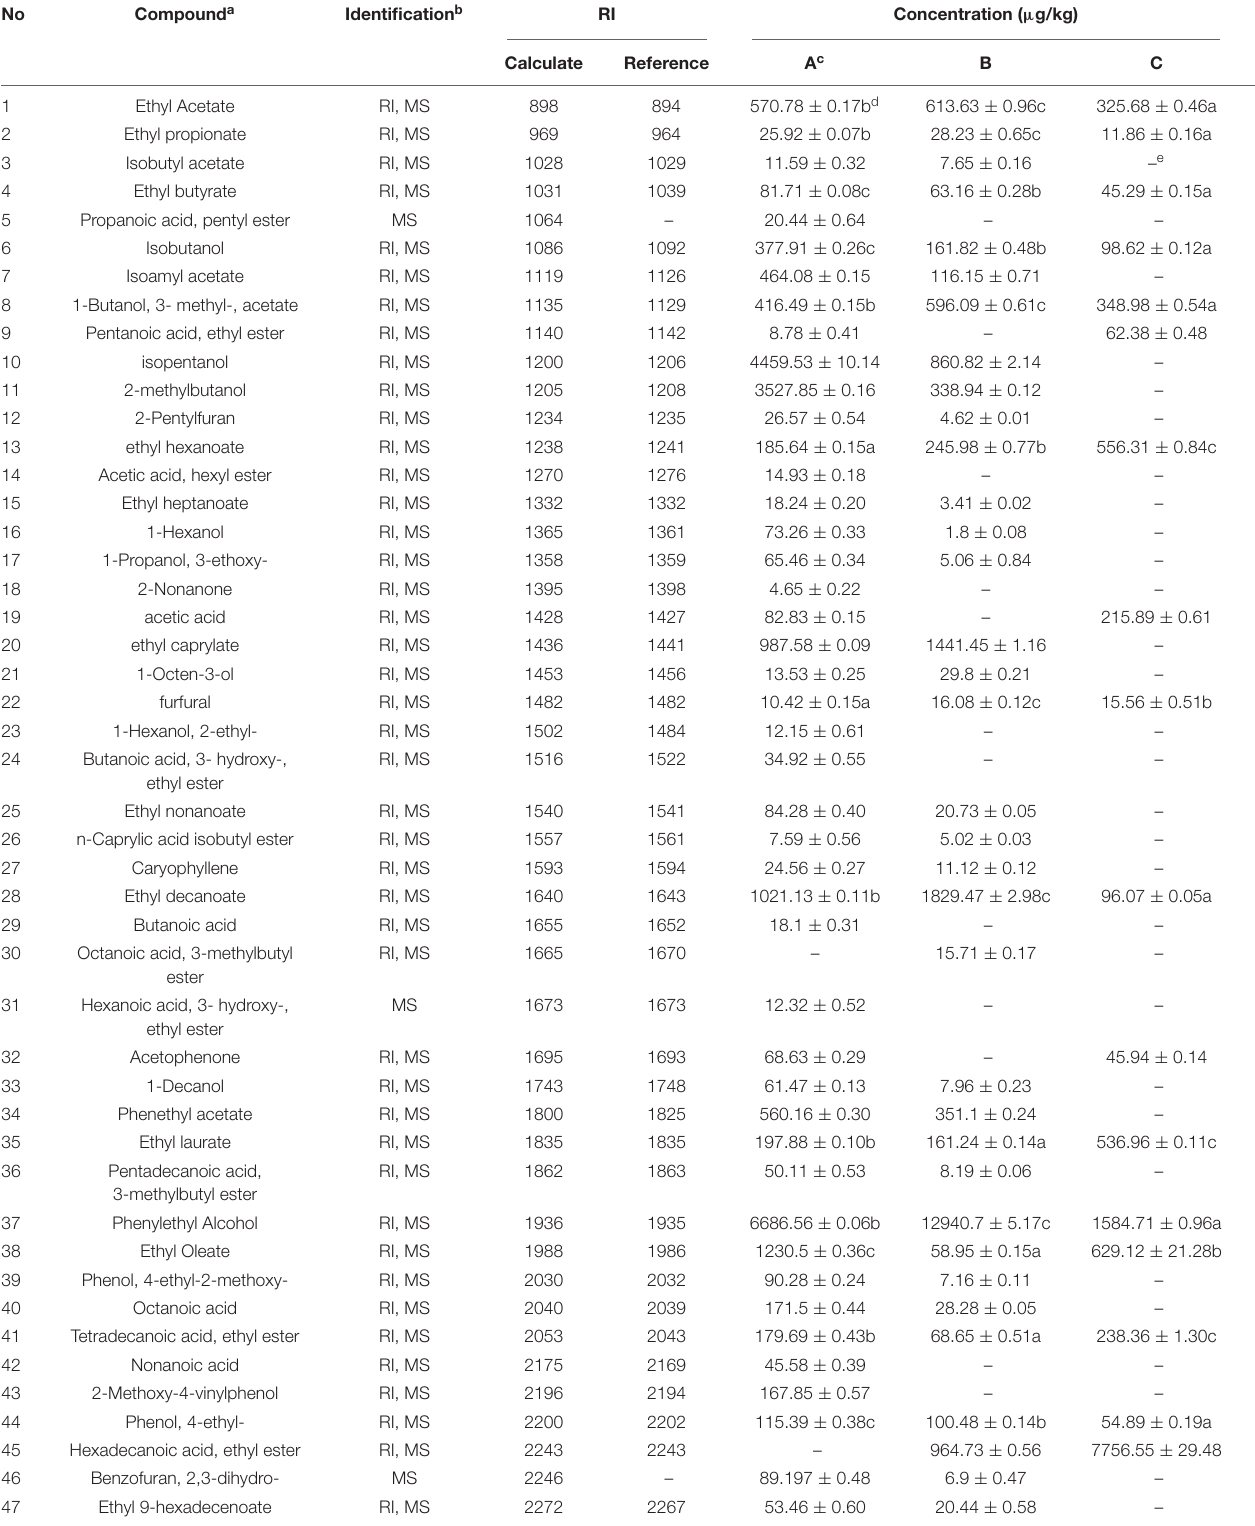
TABLE 3 | Relative contents of volatile compounds in the Chinese rice wine samples fermented by different starter cultures ( µ g/kg, n = 3), as identified by